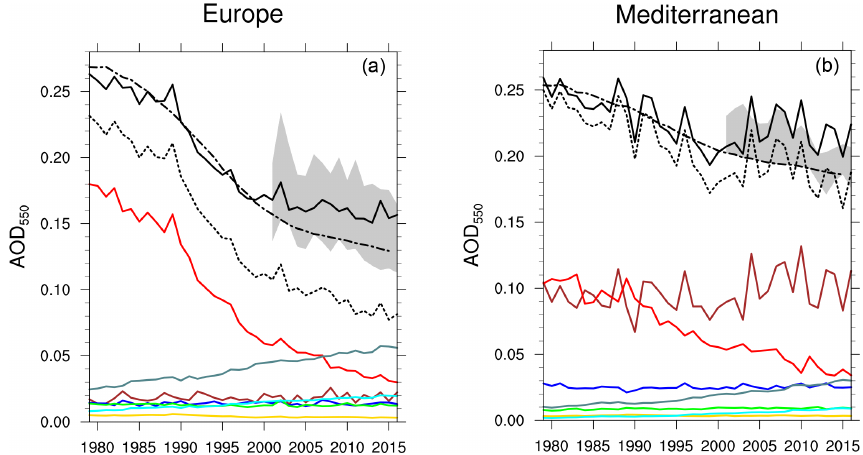
Figure 11. Yearly means of AOD 550 over Europe (a) and the Mediterranean Sea (b) as defined in Fig. 1 for the NIT simulation (solid black line), the REF simulation (dotted black line), the NAB2013 climatology (dotted dashed black line) and for each aerosol species in NIT (solid colour lines) over the period 1979–2016 compared to satellite products (grey area from 2001 on). Dust in brown, sea salt in blue, black carbon in gold, organic carbon in green, sulfate in red, ammonium in cyan and nitrate in sea green. Table 8. NIT simulation AOD 550 trend per decade compared to NAB2013 (Nabat et al., 2013) and total AOD trend from different satellite products (MISR, MODIS Aqua and MODIS Terra) over the period 2003–2015. AOD 550 trend per decade NIT NAB2013 MISR MODIS A MODIS T (2003–2015) Total A&N Dust Sulfate Europe − 0 . 006 0.013